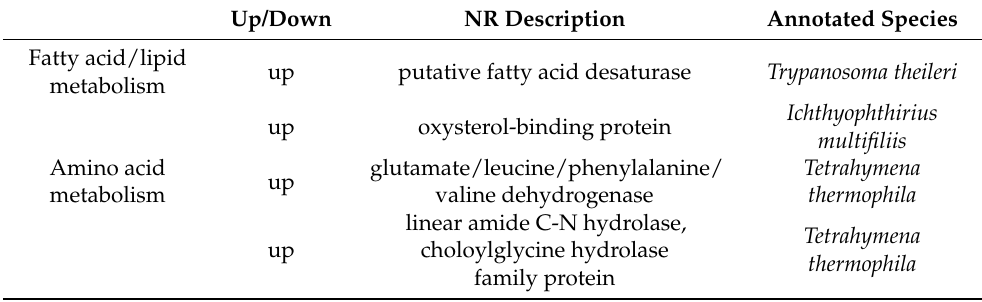
Table 2. Significantly up- or downregulated expressed genes in the parasitic C. uncinata compared to the free-living C.